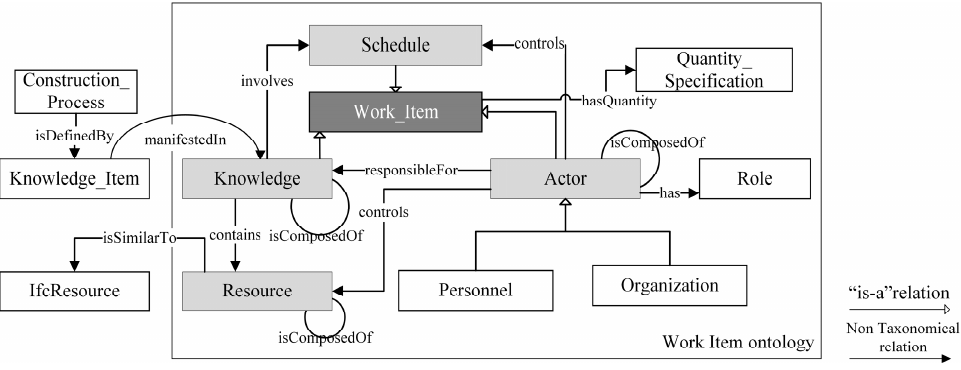
Figure 4. Framework of the work item ontology.